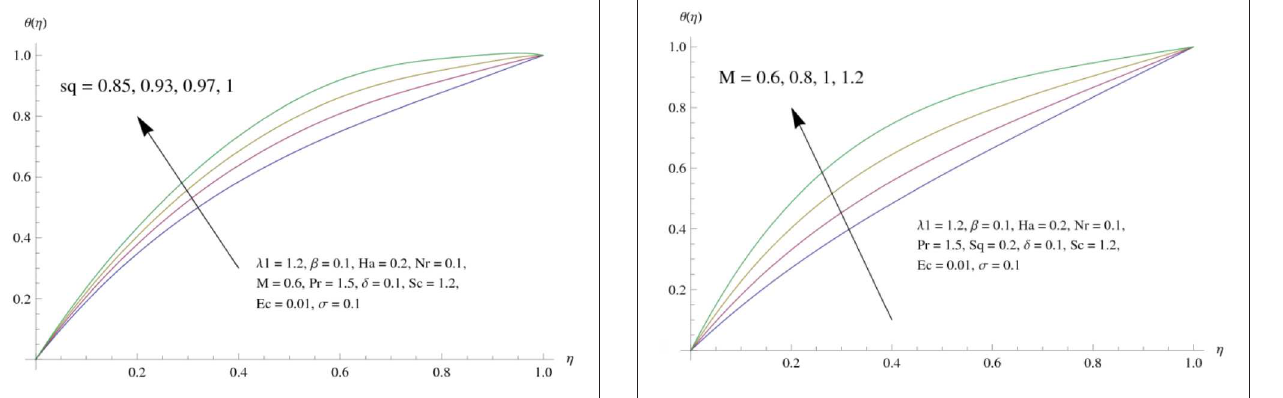
FIGURE 10 | Behavior of M on θ (η) .